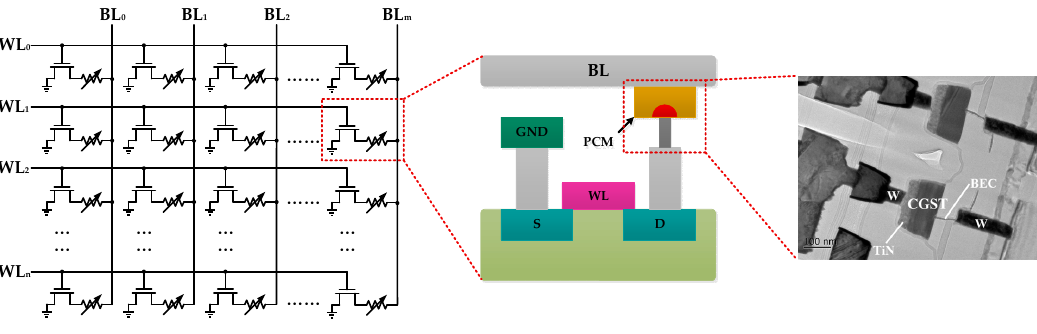
Figure 1. The storage array of phase change memory and the TEM image of a phase change memory (PCM) cell.